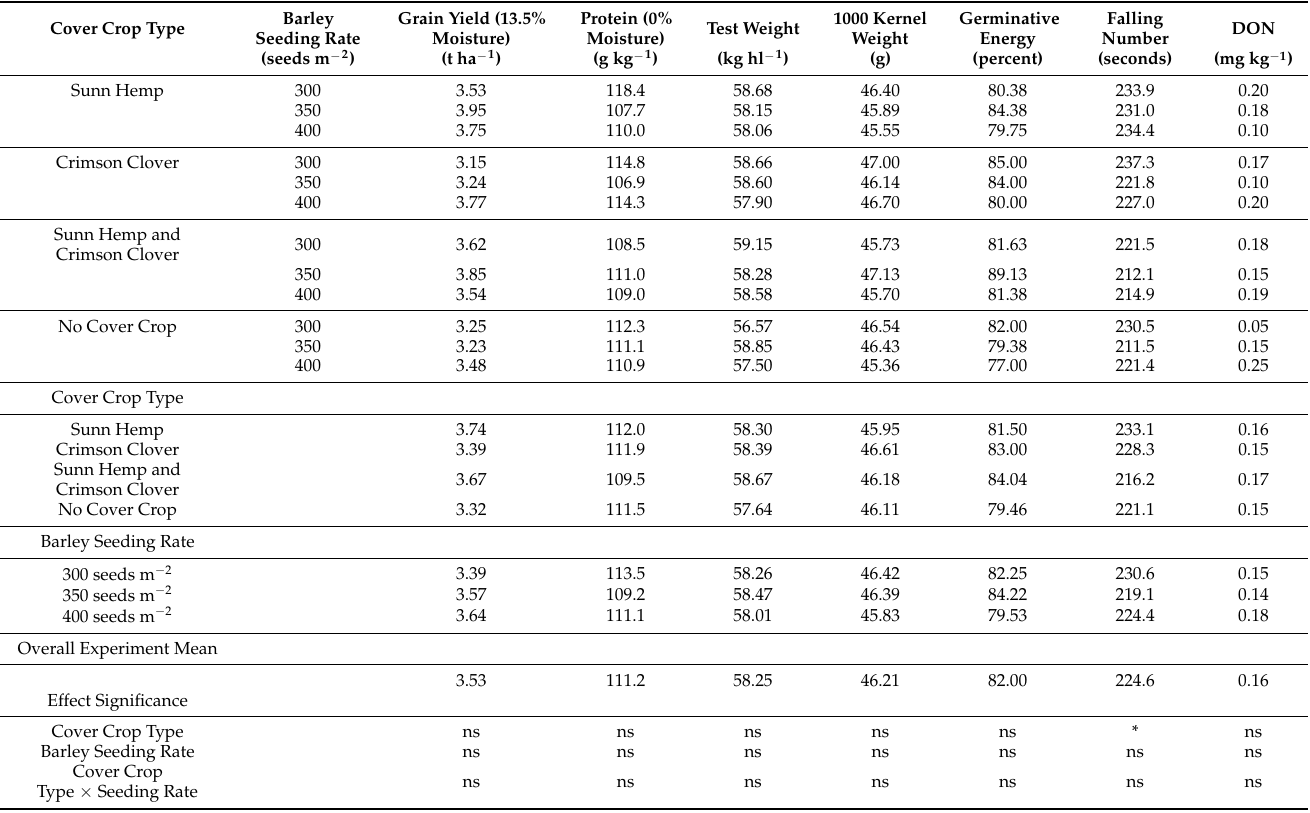
Table 5. Mean grain yield and quality metrics for winter malting barley following different cover crops and barley seeding rates in South Deerfield MA in 2014–2015 and